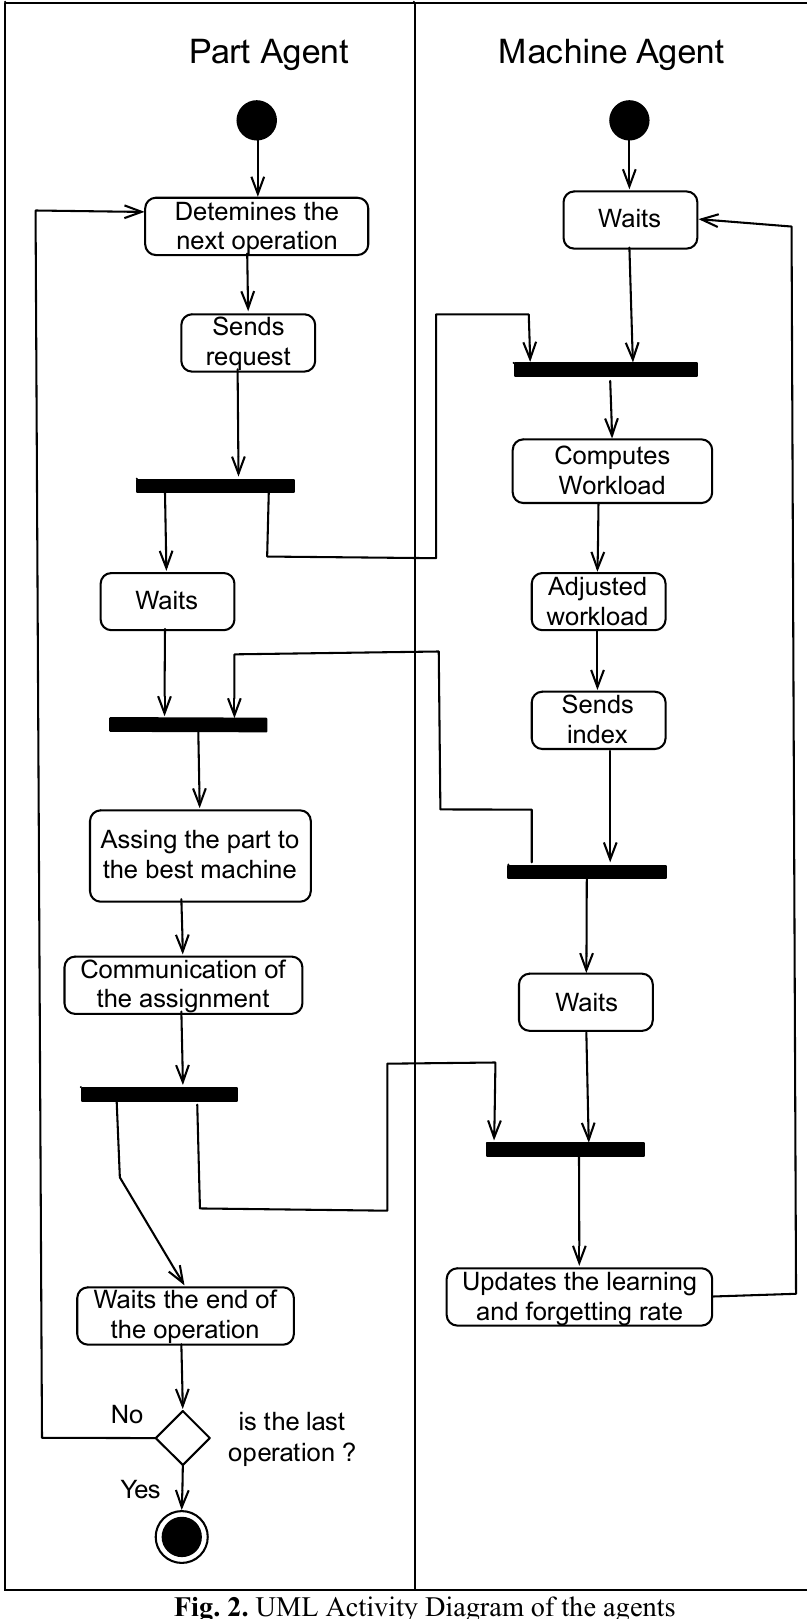
Fig. 2. UML Activity Diagram of the